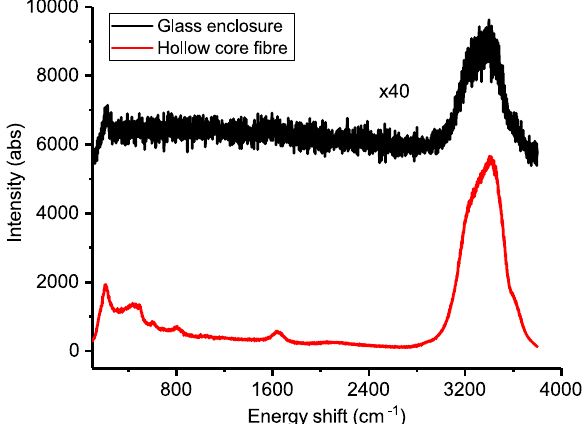
Figure 6. Raman spectra of polystyrene nanoparticles in aqueous solution measured in the bulk solution in the glass enclosure (black) and in the HC-PCF (red). Both measurements were made with the same measurement parameters (e.g., optical power, acquisition time). To enable comparison between the two spectra, the bulk solution spectra has been multiplied by a factor of 40 as